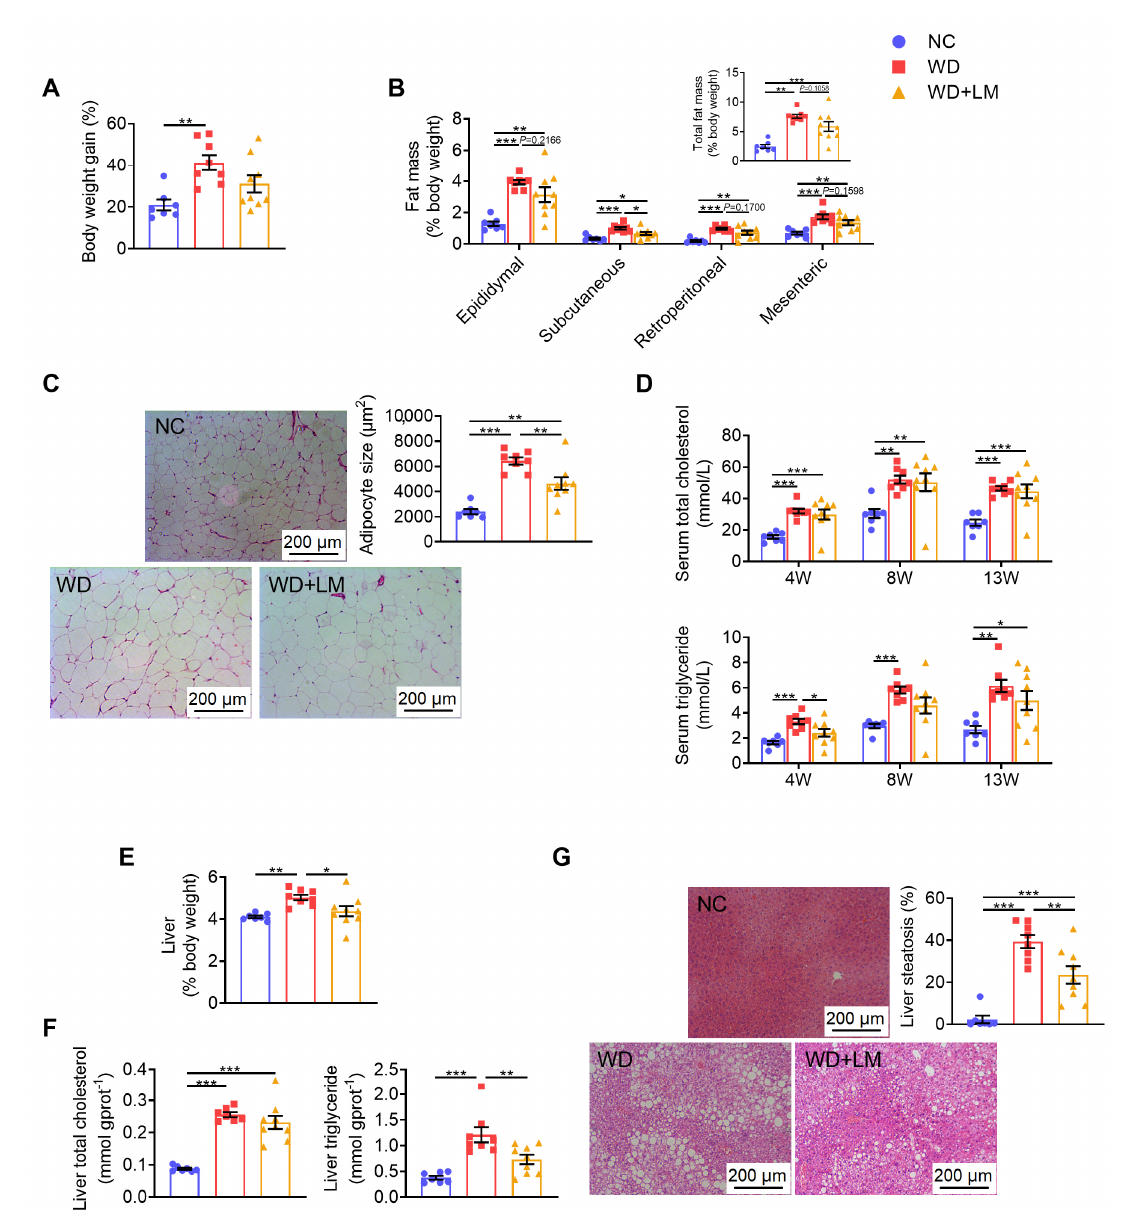
Figure 2. L. mucosae A1 alleviated lipid accumulation of ApoE - / - mice fed with a Western diet. ( A ) Body weight gain measured at the 13th week as the percentage of baseline weight for each mouse. ( B ) Epididymal, subcutaneous, retroperitoneal, mesenteric and total adipose tissue weight (ratio to body weight). ( C ) Representative photomicrographs of hematoxylin and eosin (H&E)-stained sections of epididymal adipose tissue (eAT) under 100 × magnification and mean cell area of adipocyte in eAT. The scale bar is 200 µ m. ( D ) The level of total cholesterol and triglyceride in serum collected at the 4th, 8th and 13th week. ( E ) Liver weight (ratio to body weight). ( F ) The level of total cholesterol and triglyceride in liver. ( G ) Representative photomicrographs of H&E-stained sections of liver under 100 × magnification and volume density of liver steatosis. The scale bar is 200 µ m. All the data are shown as means ± s.e.m. NC: n = 7, WD: n = 8, WD + LM: n = 9. Values of each group were analyzed by one-way analysis of variance (ANOVA) followed by Tukey’s post hoc test. * p < 0.05, ** p < 0.01, *** p <